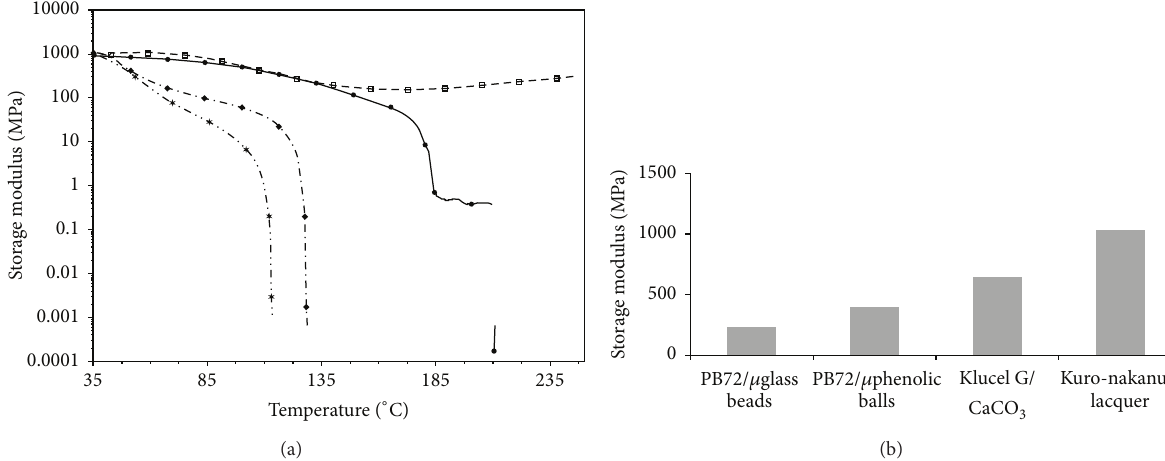
Figure 5: Storage modulus of unaged fills: ( e ) Klucel G/CaCO 3 , ( X ) PB72/ 𝜇 phenolic balls, (∗) PB72/ 𝜇 glass beads, and ( ◻ ) kuro-nakanuri